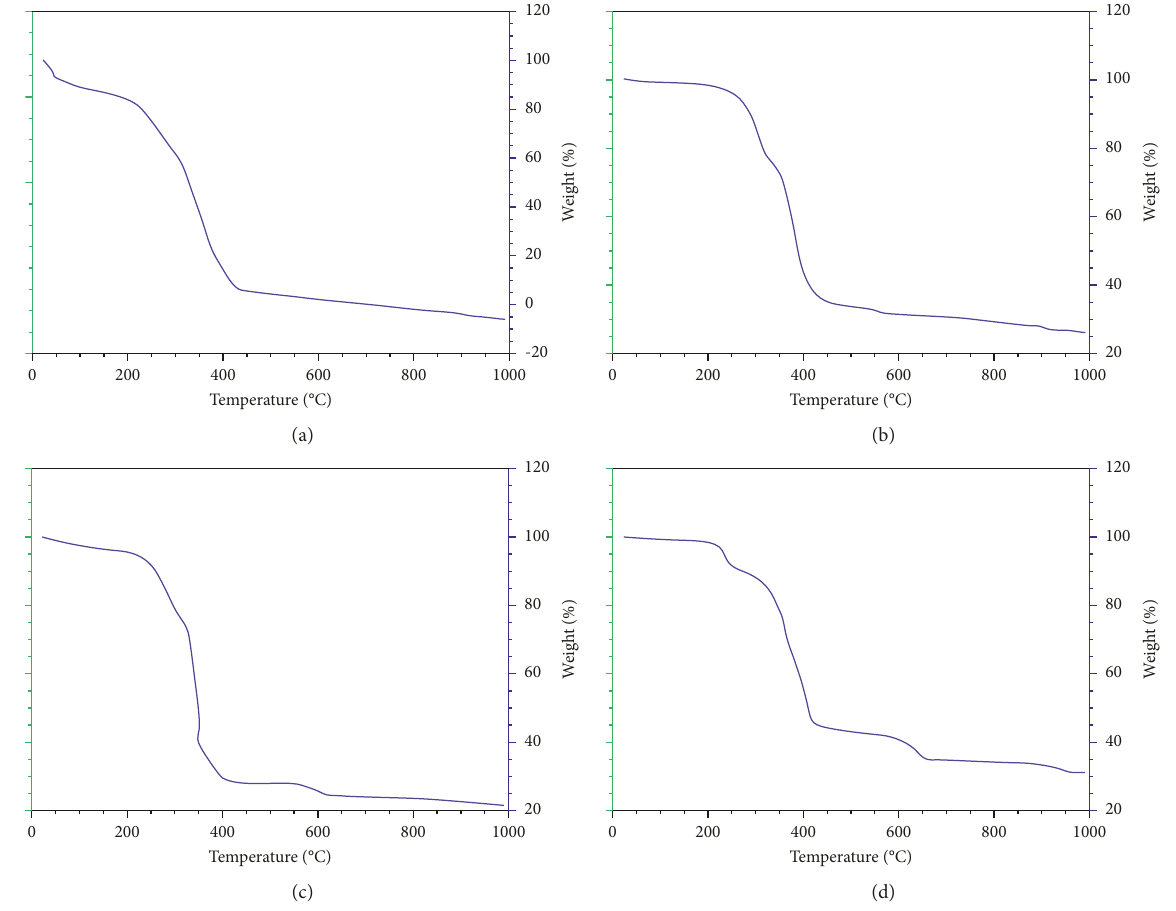
Figure 3: TGA curve for (a) LP, (b) MP, (c) WMP, and (d)